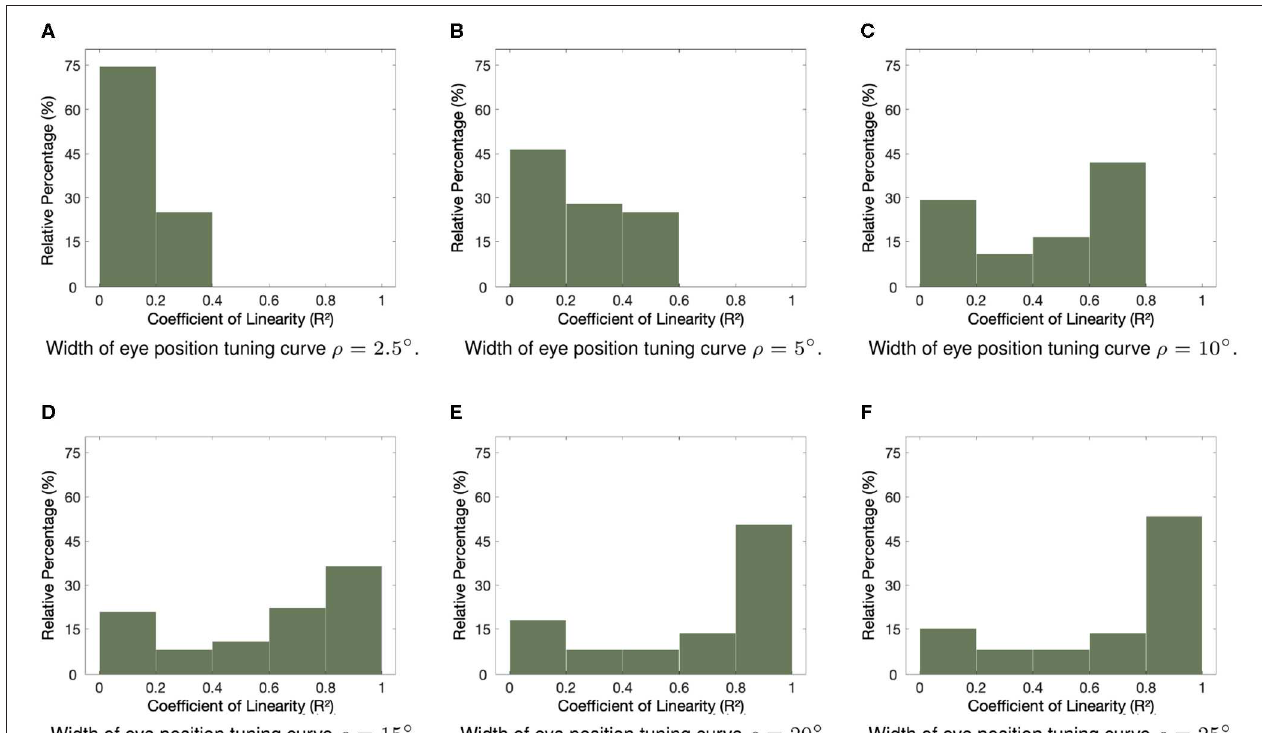
FIGURE 3 | Influence of varying the width ρ of the eye position tuning curve in the hardwired model. The subplots show how the width ρ of the eye position tuning curve affected the linearity of the eye position gain modulation of the responses of the visual neurons in the hardwired model. Simulation parameters are given in Table 1 . The coefficient of determination R 2 was calculated to assess the linearity of the response curves of each neuron when the visual stimulus was in the neuron’s preferred retinal location and the eye position varied in integer steps of one degree within [ − 35,35 ◦ ]. (A–F) show frequency histograms where individual visual neurons are binned according to their calculated value of R 2 . The plotted values are scaled to represent the relative percentages of the entire population of visual neurons. (A–C) show that the majority of responses were not linear (i.e., values of R 2 were closer to 0) for values of ρ not greater than 10, whilst (D–F) show a higher proportion of more linear responses (i.e., values of R 2 closer to 1) for greater values of ρ . These simulation results show a clear increase in the linearity of the visual responses caused by an increase in the width of the eye position tuning curve.